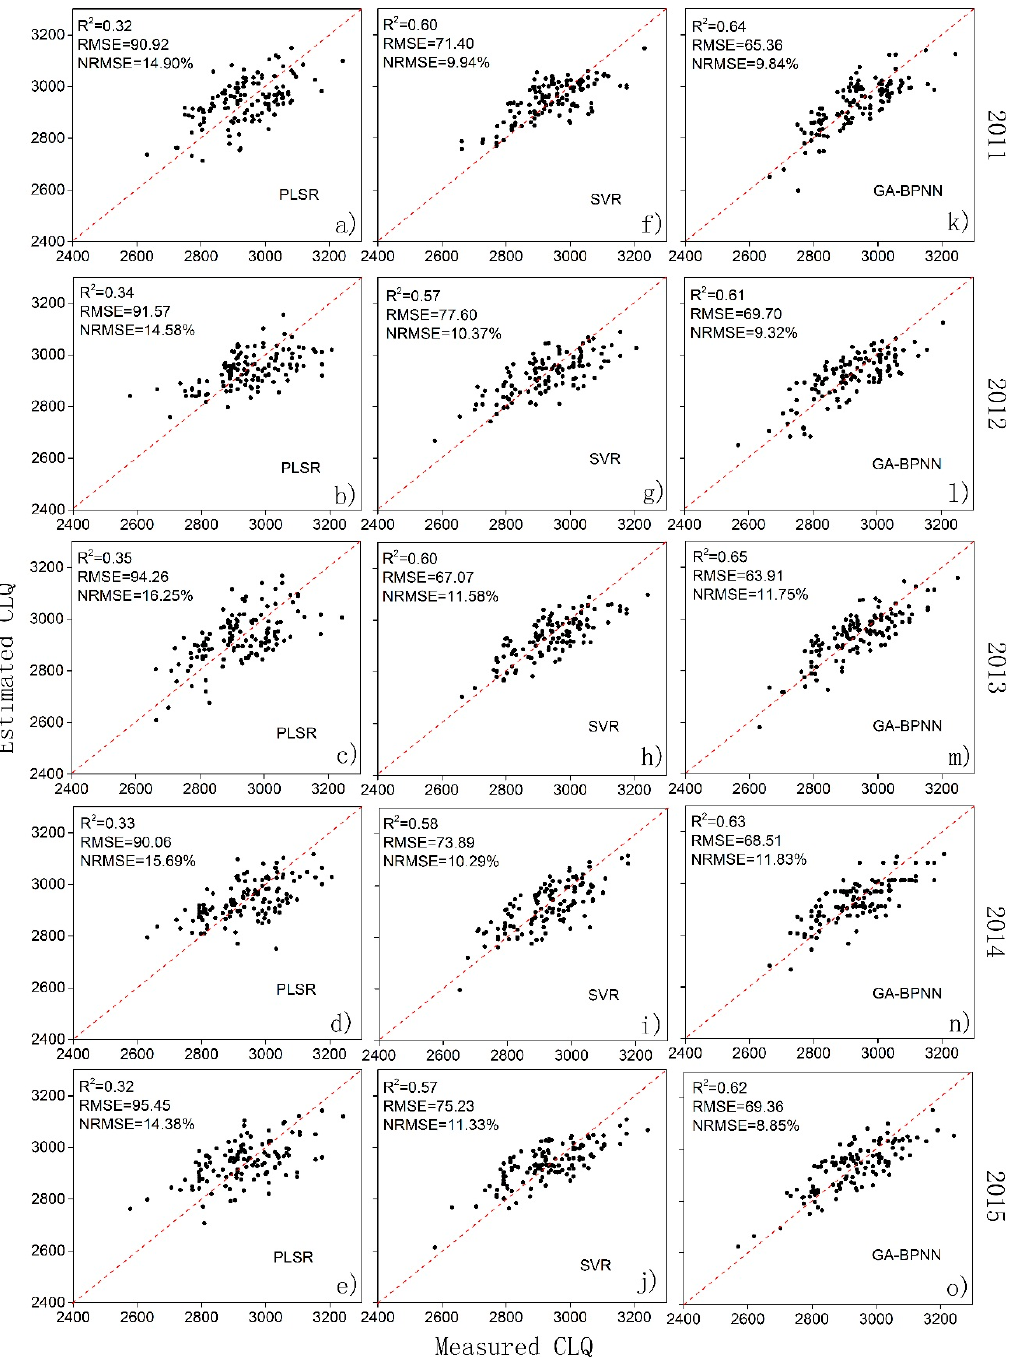
Figure 5. Scatterplots of measured versus estimated values of CLQ using the validation data set of 126 samples from 2011 to 2015: ( a – e ) PLSR model; ( f – j ) SVR model; ( k – o ) GA-BPNN model.